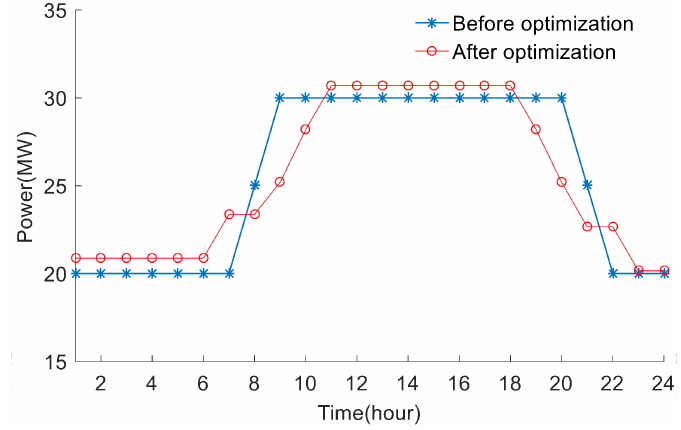
Figure 9. DC tie line power between interconnected regions before and after